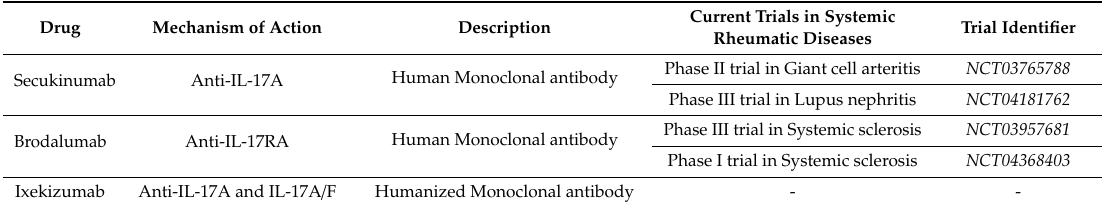
Table 1. Ongoing clinical trials on systemic rheumatic